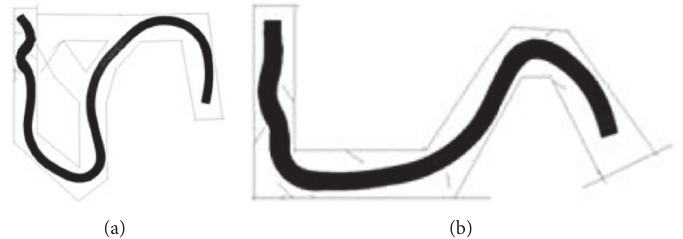
Figure 9: Simulation results of the articulated vehicle driving in different tunnels.